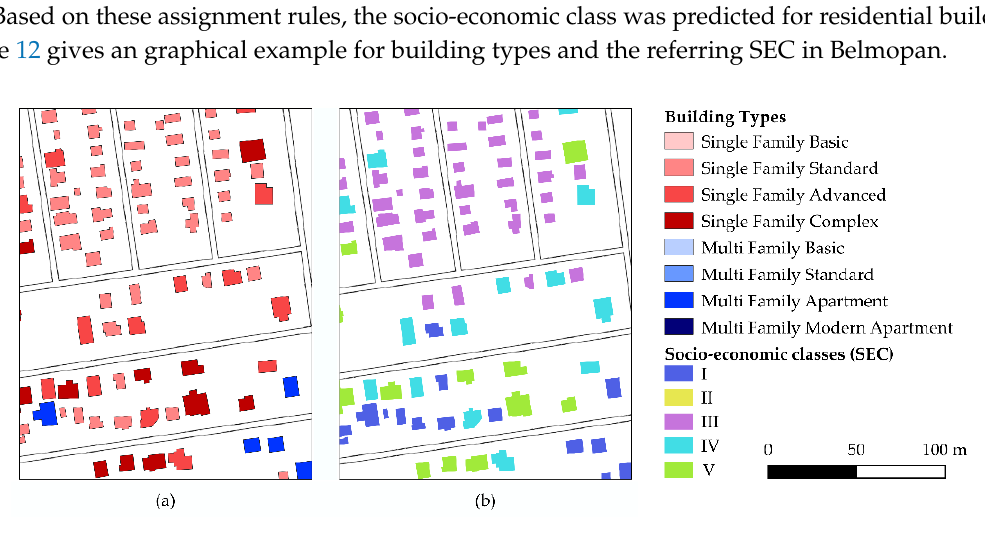
Figure 12. SEC prediction based on building types. ( a ) Building types, ( b ) SEC assignment based on rules shown in Table 7. Upper part in the legend showing building types referring to ( a ), lower part of the legend showing SEC referring to ( b